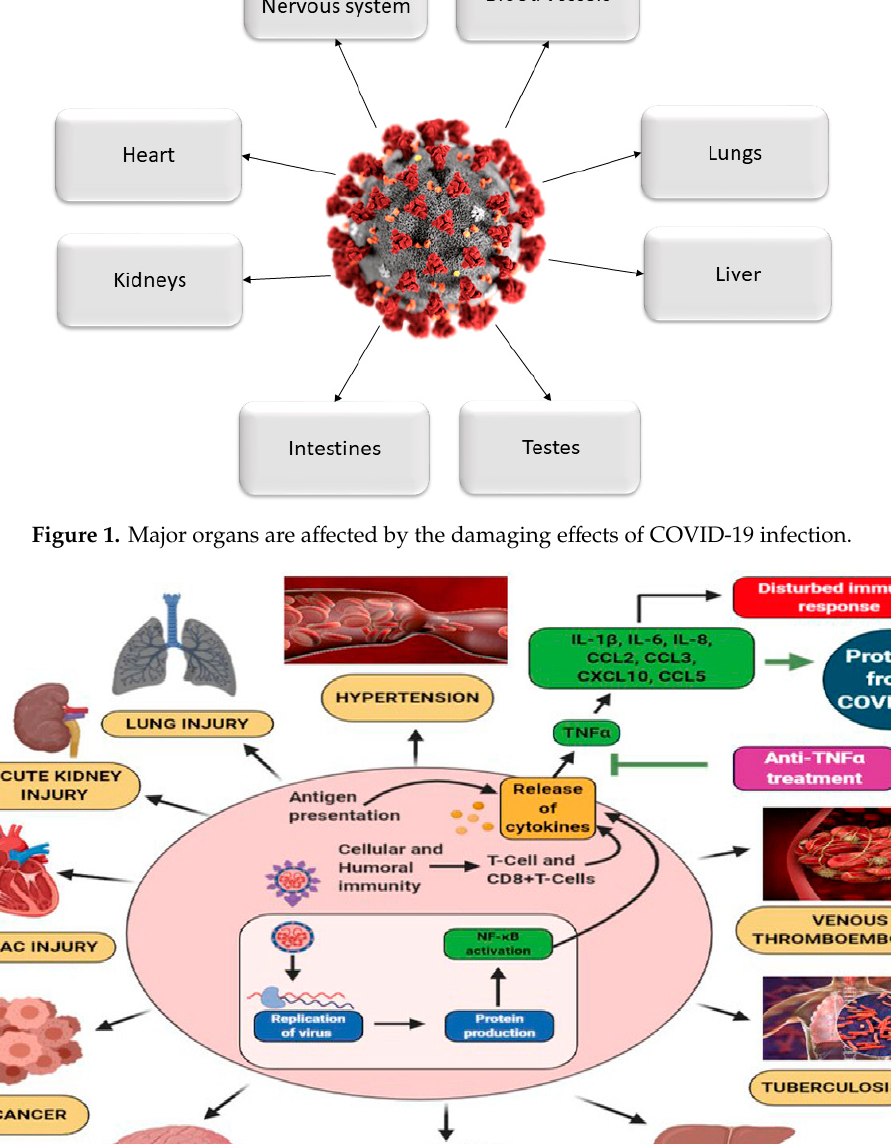
Figure 2. Coronaviruses pathogenesis, comorbidities and multi-organ damage [31].